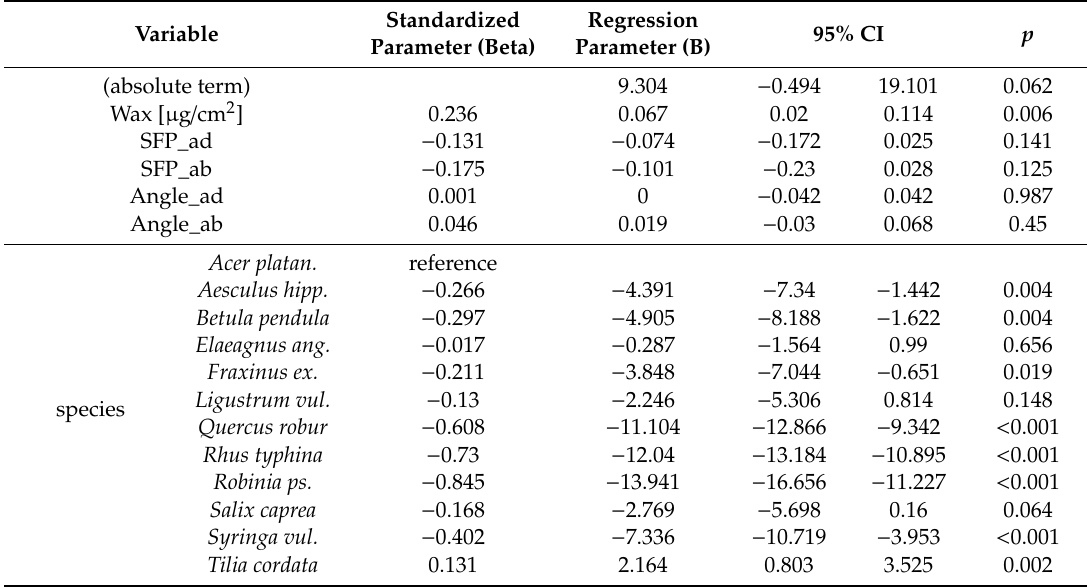
Table 2. The influence of the analysed factors on canopy water storage